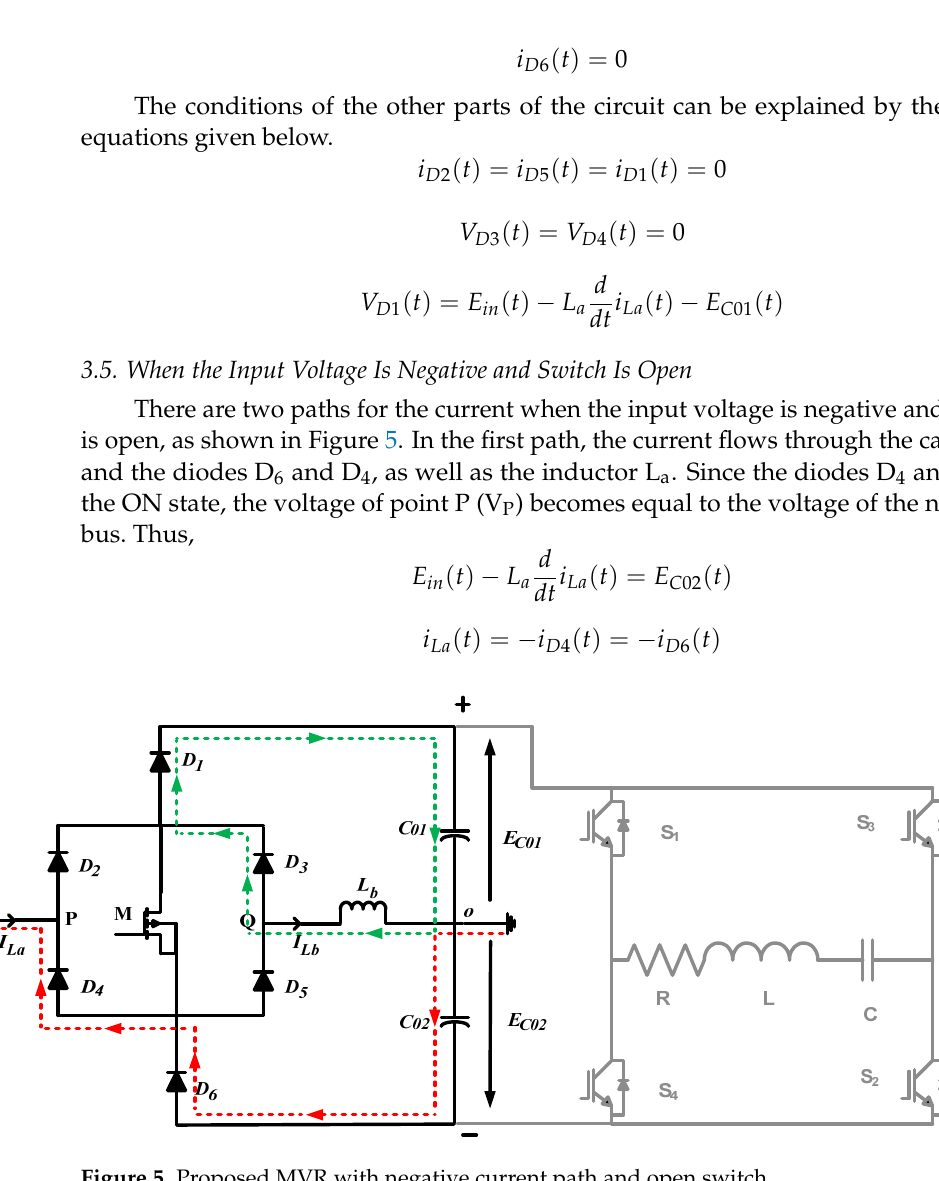
Figure 5. Proposed MVR with negative current path and open switch.